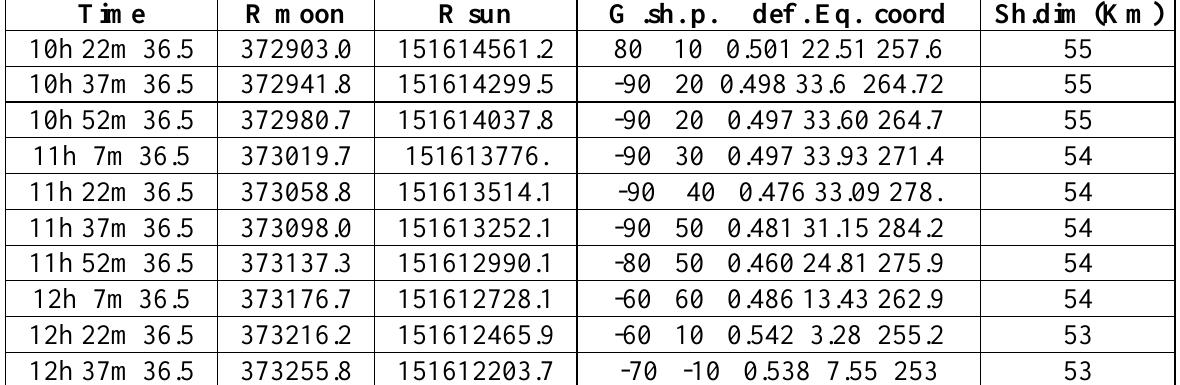
Table 4: YY = .5053345262 Total CENTRAL ECLPSE